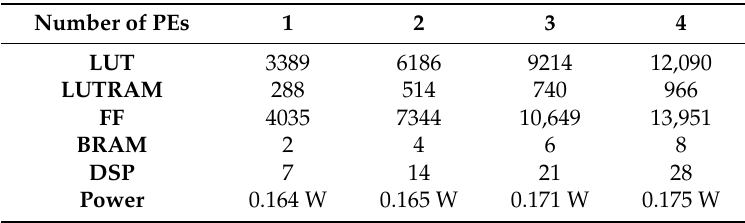
Figure 9. Place and route of proposed architecture inside ZYNQ. Table 1. Resource utilization of PL.